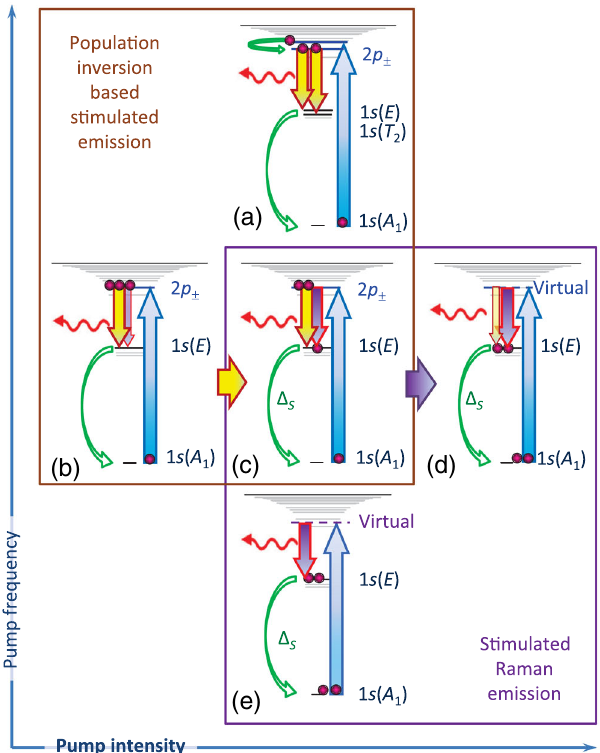
FIG. 1. Different lasing schemes in Si ∶ Bi lasers. The transition between these schemes depends on the pump frequency, pump intensity, and time that has elapsed after the start of the pump pulse. The horizontal gray and black lines indicate the discrete energy levels of the Bi donor. The straight blue arrows up indicate the optical pump process. The straight arrows down are for PIL (filled yellow) and SRS (filled purple) lasing, the curved arrows down are the dominating nonradiative relaxation paths of an excited electron. 1 s ð E Þ and 1 s ð T 2 Þ are split-off ground states, 1 s ð E Þ → 1 s ð A 1 Þ is a Raman-active intracenter transition in n -Si with an energy Δ . (a) PIL: four-level laser scheme based on S population inversion between the long-lived 2 p and the short- (cid:2) lived 1 s ð E Þ , 1 s ð T 2 Þ states; depletion of the lower laser states into the ground state is due to intervalley phonons. (b) – (d) merged PIL and SRS lasing processes under resonant pumping into the long- lived 2 p state. In this particular case the virtual state coincides (cid:2) with the 2 p state of the Bi donor. At pump start (b) PIL (cid:2) dominates, the laser scheme is reduced to the three levels; later on (c) SRS develops and balances PIL; in the end (d) SRS prevails, and the elecrons are scattered directly into the 1 s ð E Þ state, the upper 2 p level becomes essentially unpopulated. (e) SRS lasing (cid:2) occurs at off-resonant pumping to any of the higher impurity